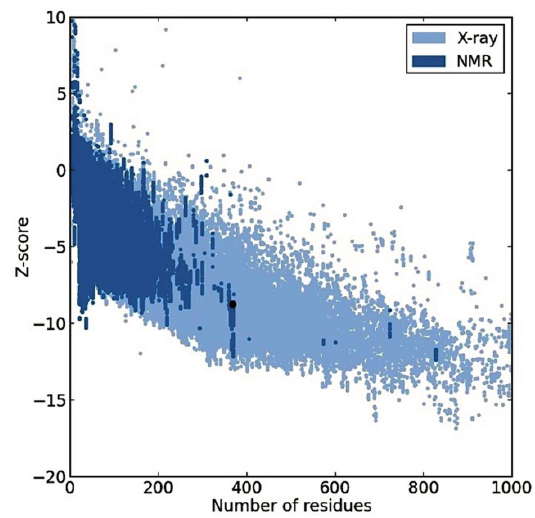
Figure 4. Protein Structure Assessment server (ProSA-web) result of the Plasmodium falciparum histone deacetylase1 Pf HDAC1 homology model; the black dot represents the model z